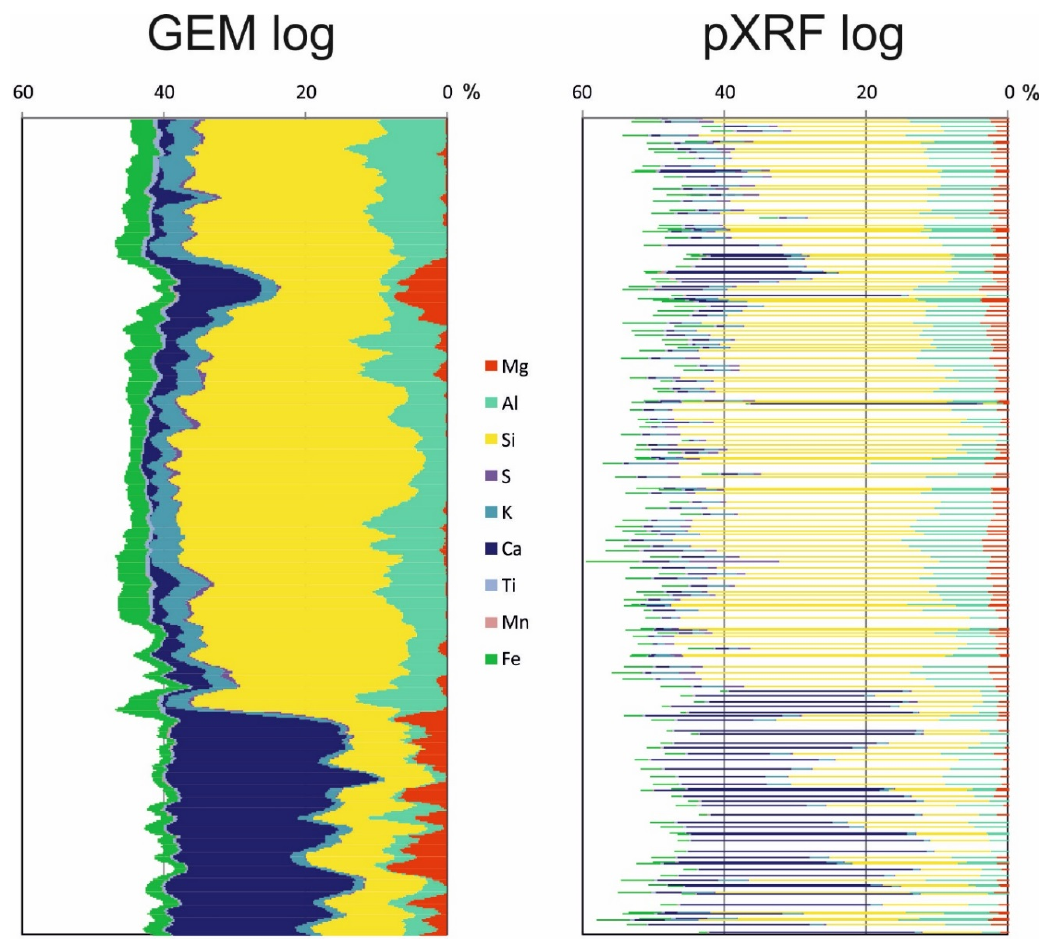
Figure 1. Comparison of a chemical composition variability profile obtained with the use of a GEM probe with the one developed based on measurements taken with a portable pXRF spectrometer in a clay profile.